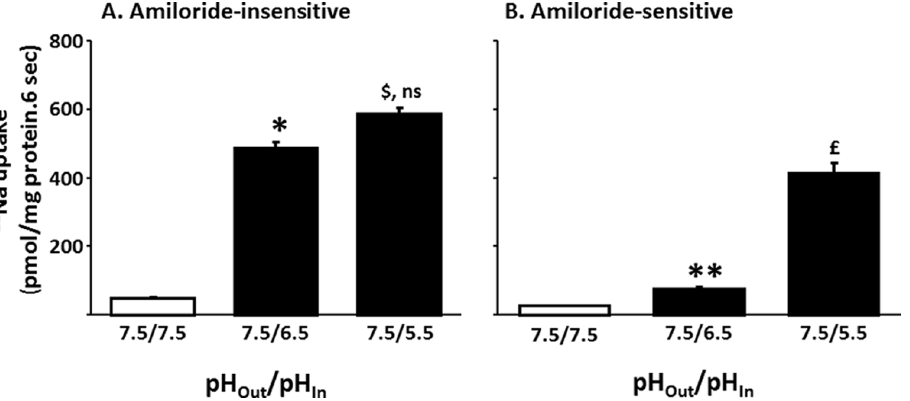
Figure 9. Effect of varying outward acid pH-gradients on Na-HCO 3 cotransport activities in basolateral membrane vesicles from proximal colon. Proton/HCO 3 gradient-driven 22 Na uptake (0.1 mM) was measured as described in the Method section with different extravesicular pH in presence and absence of inhibitors (1 mM amiloride or 1 m M HOE694). Both one-unit (pHo/pHi: 7.5/6.5) and two-unit (pHo/pHi: 7.5/5.5) outward acid pH-gradients stimulated the amiloride-insensitive Na-HCO 3 cotransport. A two-unit, but not a one-unit outward acid pH gradient stimulated amiloride-sensitive Na-HCO 3 cotransport. Uptake obtained in presence of amiloride represented amiloride-insensitive proton/HCO 3 gradient-driven uptake. Amiloride-sensitive uptake (which also includes HOE694 sensitive Na-H exchange) was calculated by subtracting uptake obtained in presence of amiloride from that of uptake in the absence of inhibitors. HOE694-sensitive uptake was calculated by subtracting uptake obtained in presence of HOE694 from that of uptake in the absence of inhibitors. Amiloride-sensitive proton/HCO 3 gradient-driven uptake was calculated by subtracting HOE694-sensitive uptake from that of amiloride-sensitive uptake. * p , 0.02 compared to 7.5/7.5 (pHo/pHi) in amiloride- insensitive; $ p , 0.002 compared to 7.5/7.5 (pHo/pHi) in amiloride-insensitive; ** p , 0.004 compared to 7.5/7.5 (pHo/pHi) in amiloride-sensitive; * p , 0.001 compared to 7.5/7.5 (pHo/pHi) in amiloride-sensitive; ns: not significant compared to 7.5/6.5 (pHo/pHi) in amiloride-insensitive.